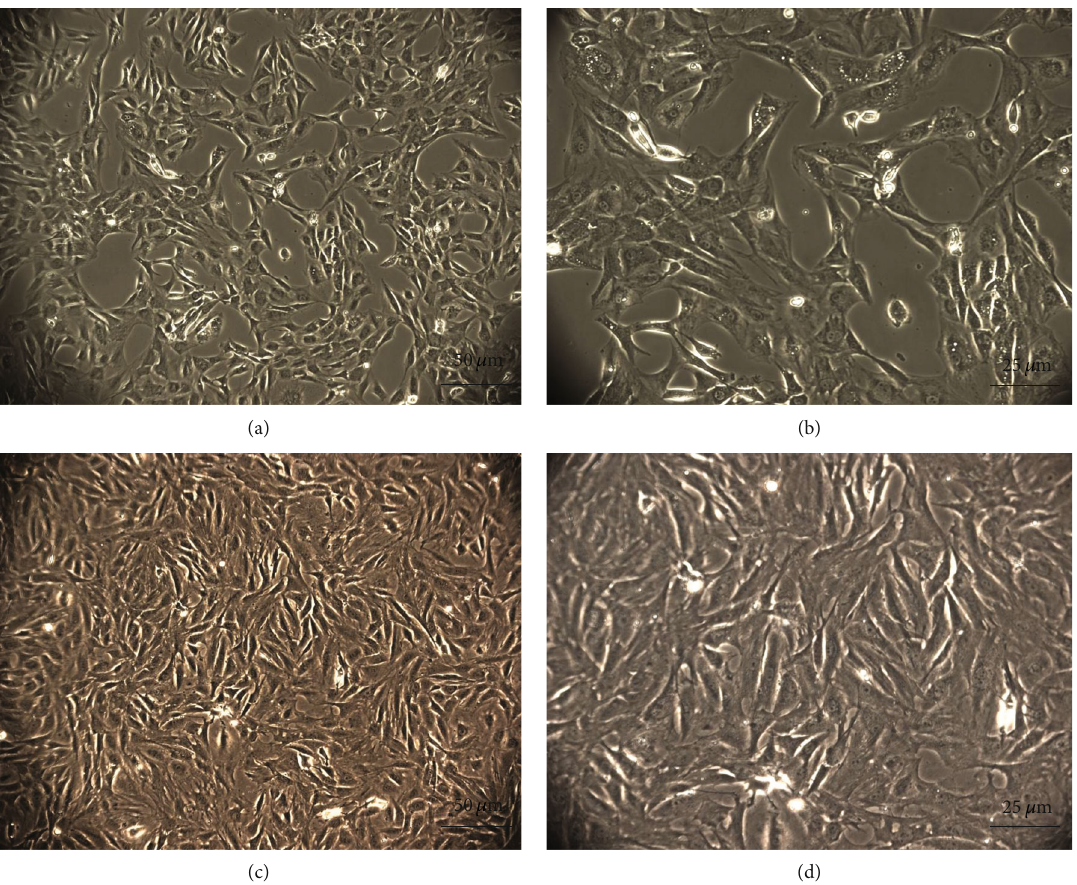
Figure 1: The microscopical appearance of the third passage generation of IPFP-MSCs from the (a, b) IPFP-MSC group and the (c, d) cell concentrate group exhibited typical spindle-shaped morphology and cells were anchorage